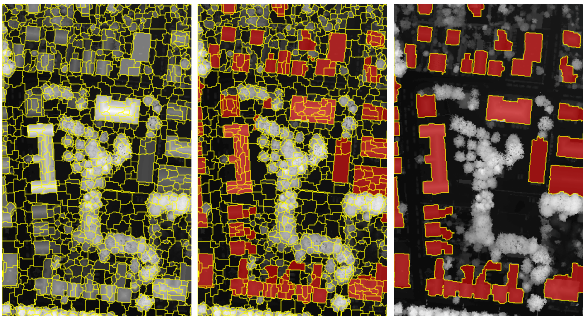
Figure 7: From left to right: basic eCognition segmentation (yellow = segment boundary), initial classification (roofs = red), classification after rule set and merging; background is the nDSM